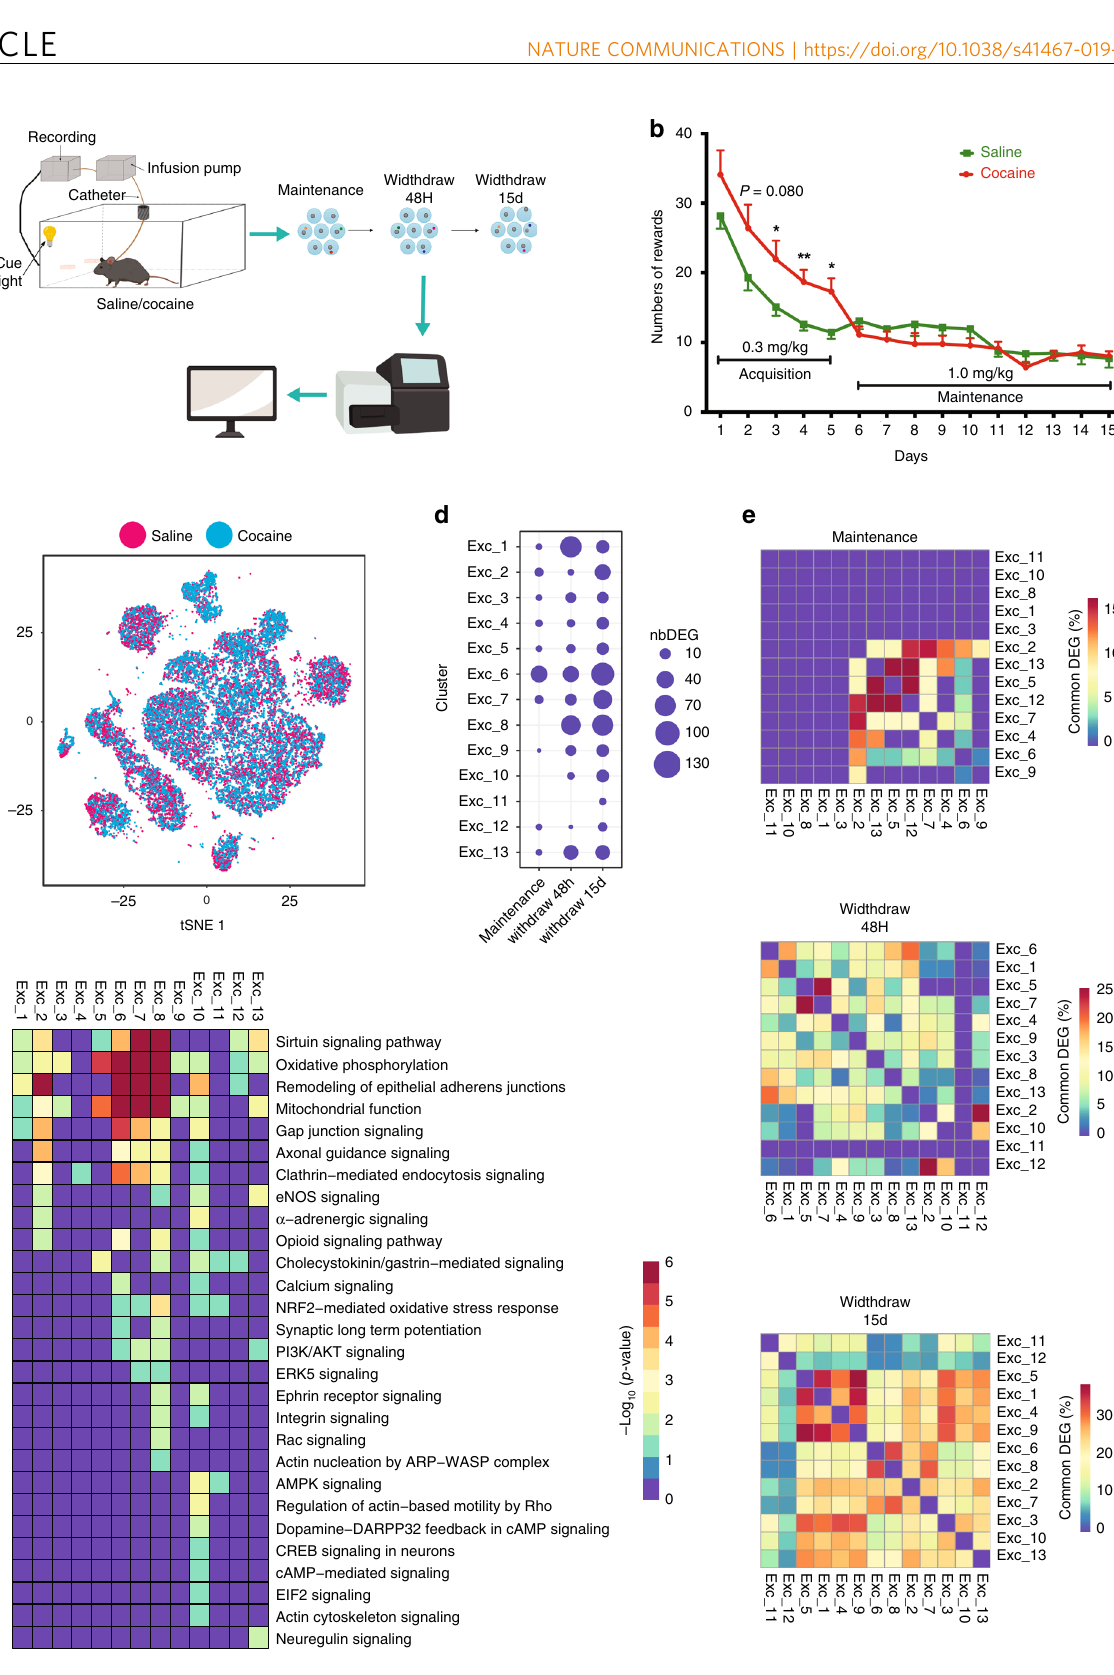
that neuroadaptations associated with addiction induces a strong neuroadaptation with altered oxidative phosphorylation, although metabolic and bio-energetic shift in the affected neuron populations. This is a fundamental difference from adaptive neuroplasticity of adolescence, where structural changes in neurons/synapses appear to play a more predominant role in NATURE COMMUNICATIONS| (2019) 10:4169